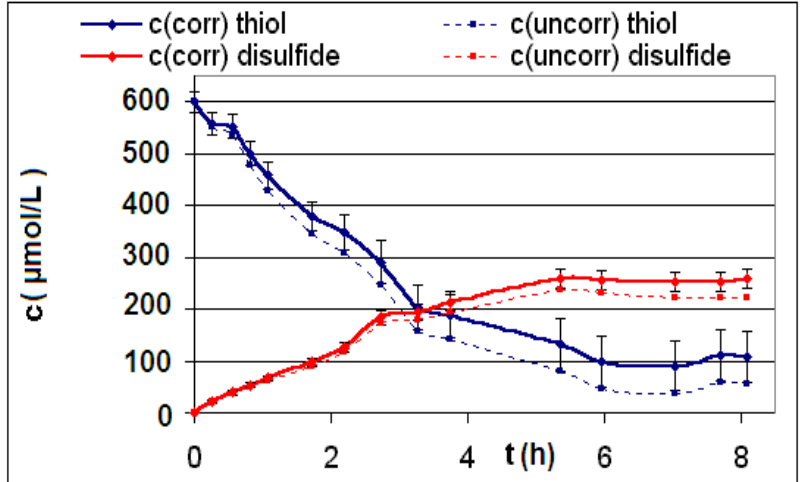
( t ) /c ( t ) corr uncorr